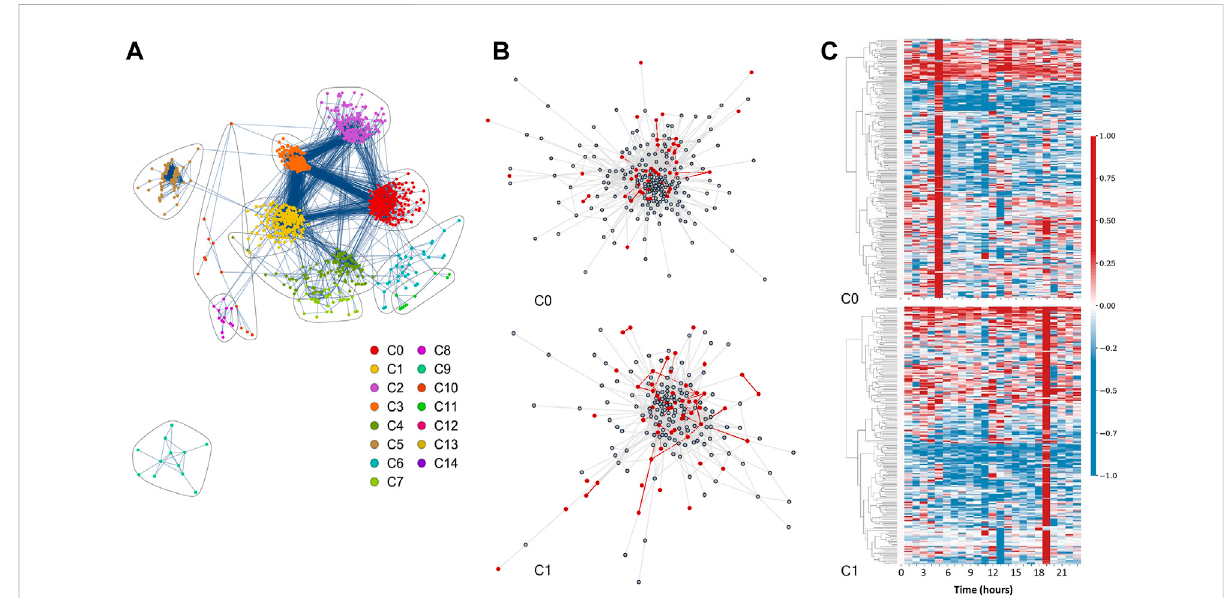
FIGURE 2 Differential network analysis for the saliva experiment. (A) Differential network with community structure found by the Louvain community detection method. (B) Isolated visualizations of C0 (top) and C1 (bottom) communities with red highlights indicating genes found in statistically signi fi cant Reactome pathways (FDR < 0.05), and their corresponding edges in the network. (C) Heatmaps of C0 (top) and C1 (bottom) over 24 h. Columns represent time points while rows denote gene identi fi ers.The row data show thedifference in eachentry ’ sexpressionrelative to time 0. The relative values were determined by subtracting the individual time points from time point 0 and then normalizing using a Euclidean norm, so that each row ranges from -1 (down-regulation) to 1 (up-regulation). For the dendrogram clustering we used the complete-linkage method (also known as the Farthest Point Algorithm) Defays (1977); Hartigan